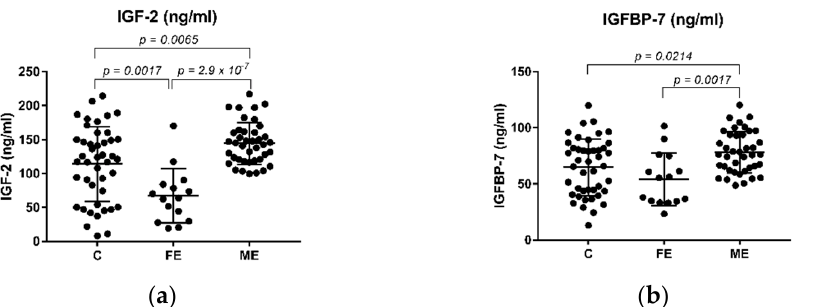
Figure 1. Plasma levels of IGF-2 (ng/mL) and IGFBP-7 (ng/mL) in SZ patients and healthy controls. ( a ) Levels of IGF-2 are significantly downregulated in the FE group when compared to the healthy control and the ME groups; ( b ) Levels of IGFBP-7 are significantly downregulated in the FE group compared to the ME group. Tukey’s multiple comparison test was used, and significant p -values are shown in each graph. FE: First Episode drug-naïve patients, ME: multiple or chronic patients.